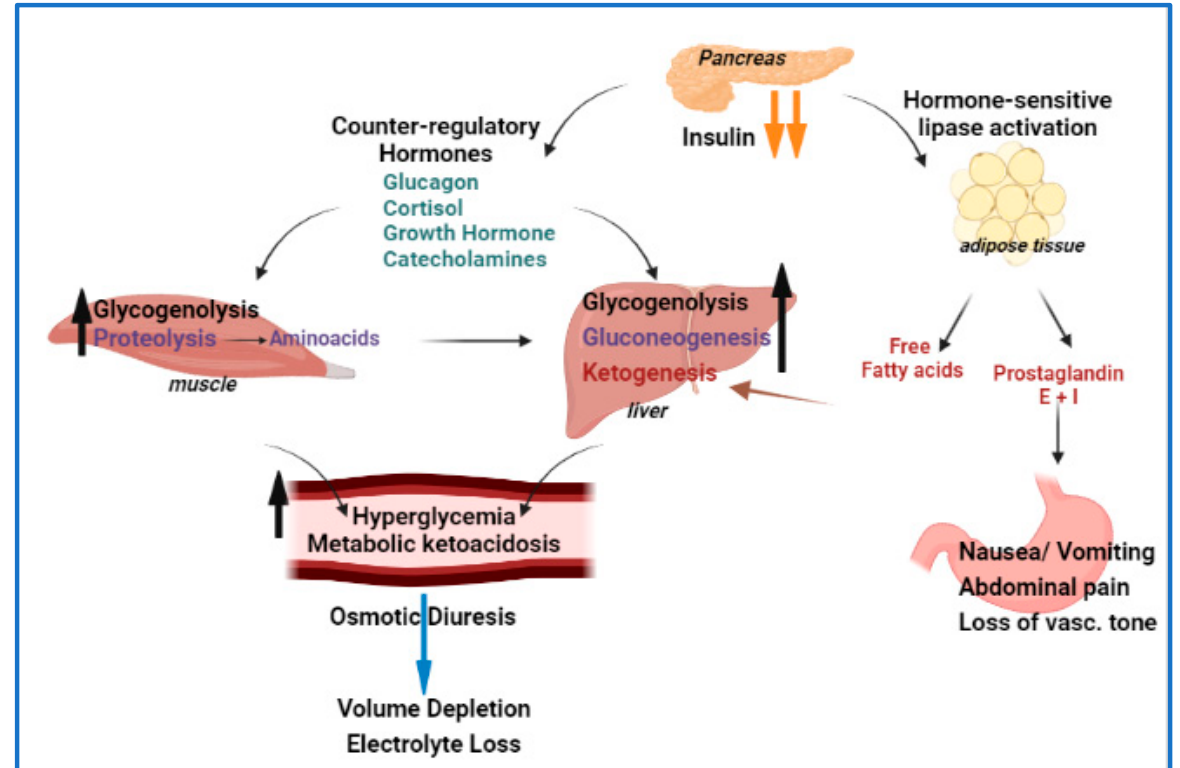
Figure 1. Schematic framework of the pathophysiology of diabetic ketoacidosis. In DKA, insulin insufficiency sets off a cascade of maladaptive physiologic responses involving activation of lipase, increased free fatty acids that triggers excessive ketone bodies leading to metabolic acidosis. Acti- vation of counter regulatory hormones drive hyperglycemia via various mechanisms including in- creased glycogenolysis, gluconeogenesis resulting in progressive volume depletion and electrolyte loss.